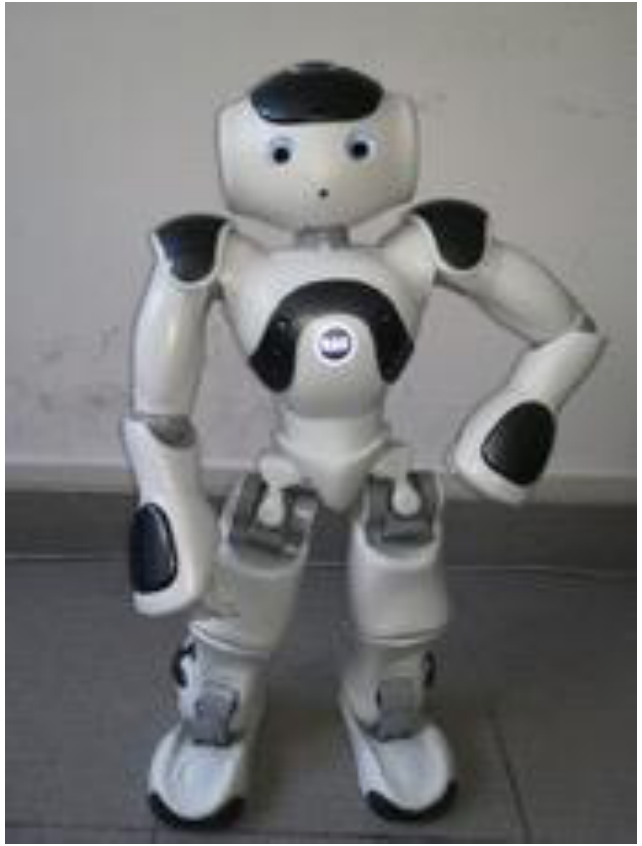
Figure 2. NAO robot v6 from SoftBank Robotics employed in the experiment.